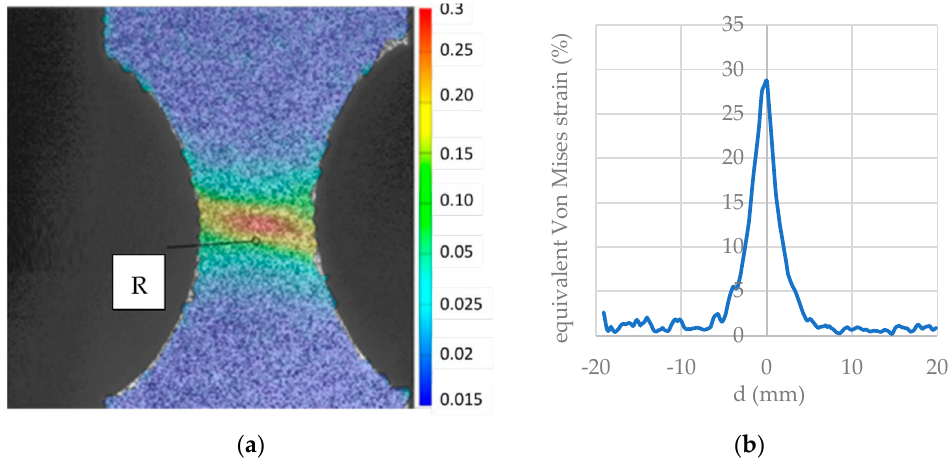
Figure 26. ( a ) Equivalent Von Mises strain across specimen longitudinal section; ( b ) Equivalent Von Mises strain across specimen longitudinal section.